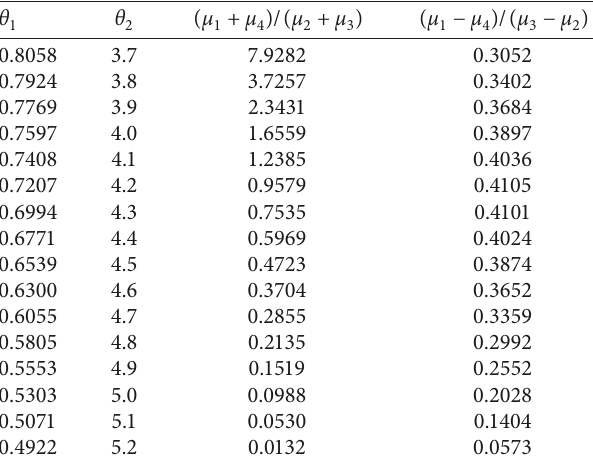
Table 3: Some numerical results of θ ( μ